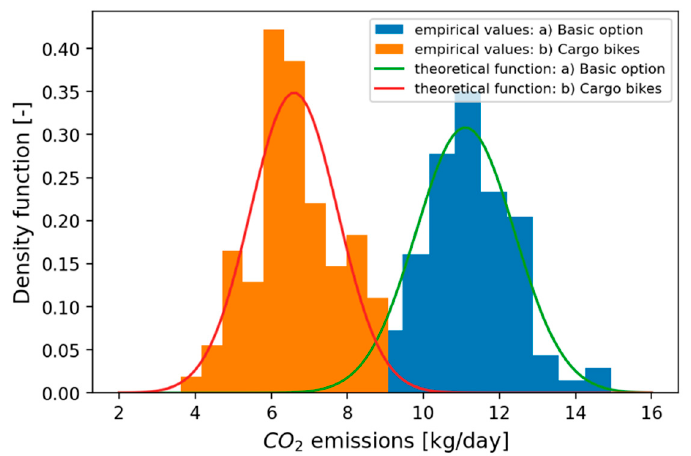
Figure 6. Distribution of the CO 2 emissions based on the results of simulations for Vitoria-Gasteiz.